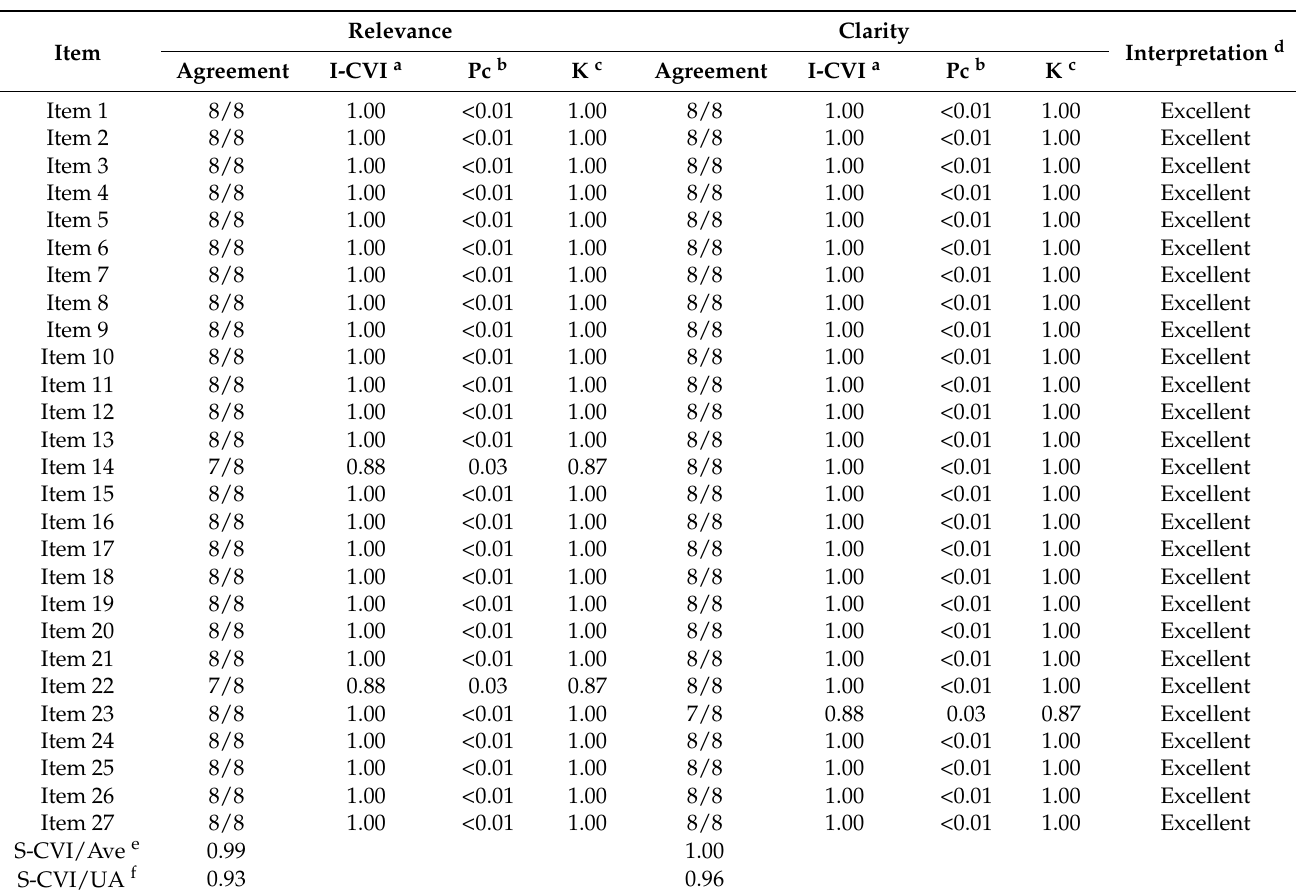
Table A2. Content validity index of item relevance and clarity, and modified kappa agreement for the ISS through the expert panel ( N =